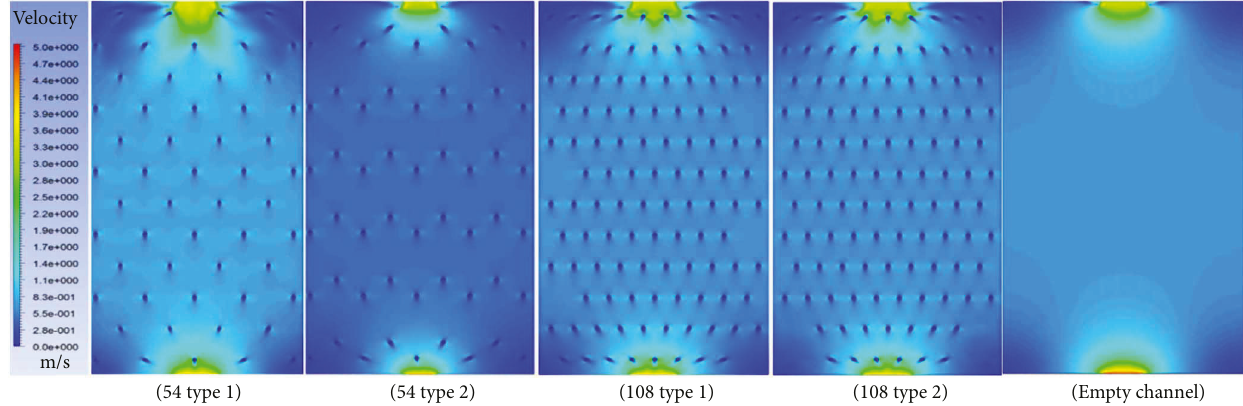
Figure 16: Velocity contours at